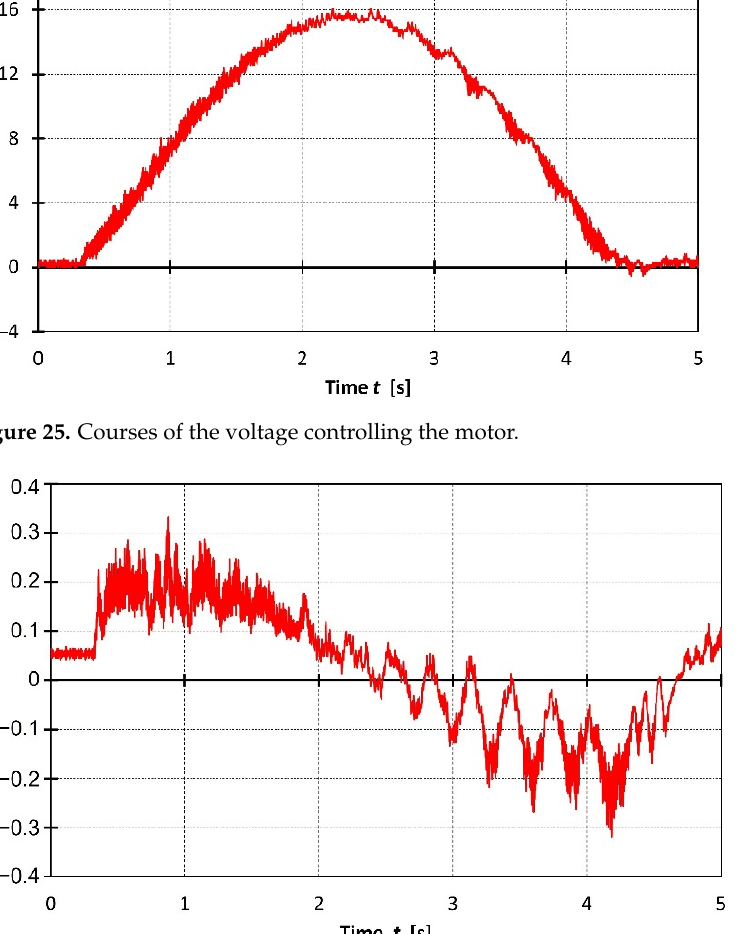
Figure 26. Current consumed by the motor.